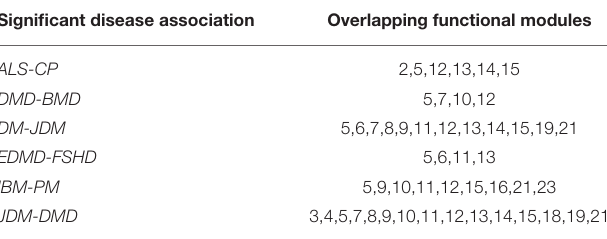
This table represents the functional modules identified as overlapping (p < 0.05) between the significant diseases associations identified on the left. The overlapping functional modules are identified using the IDs presented in Table 2